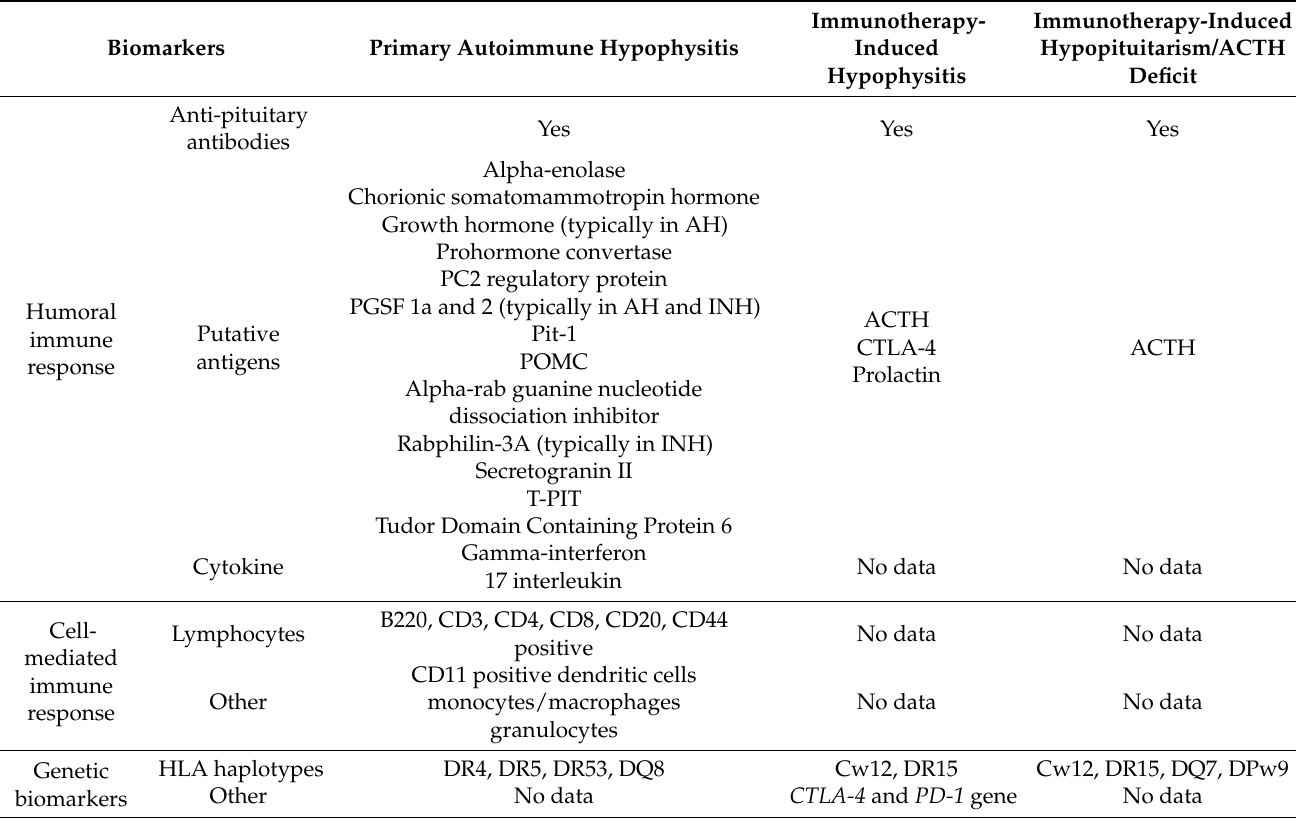
Table 2. Biomarkers in primary autoimmune and immune-therapy induced hypophysitis, hypopituitarism and ACTH